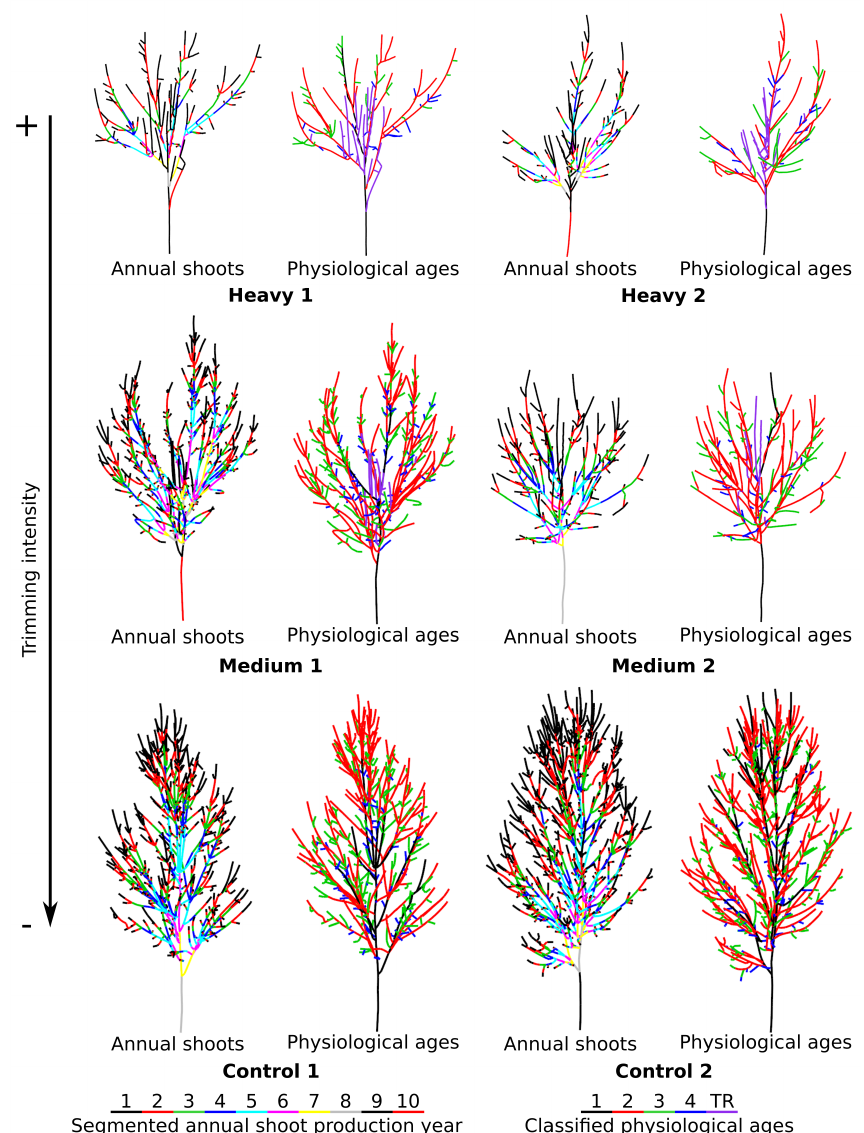
Figure 15. Skeletons of six red ashes from a trimming experiment obtained with the SimpleTree QSM model with segmented annual shoots (Segmented) and annual shoots classified into four physiological ages (Classified) using the parameters described in Table 1. In the classified annual shoot, TR (purple) corresponds to traumatic reiterations that occurred after tree